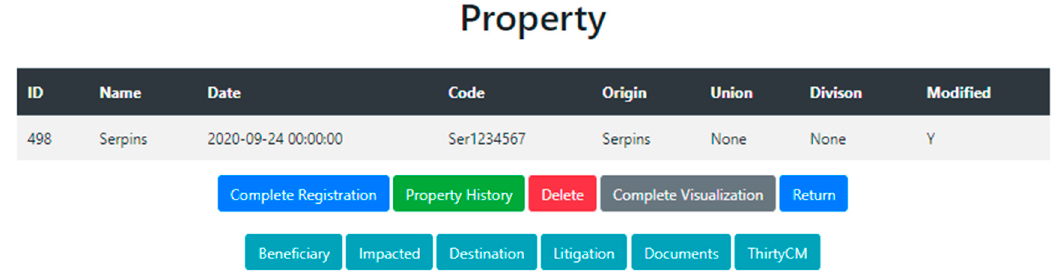
Figure 9. Property “Serpins” (ID = 498).